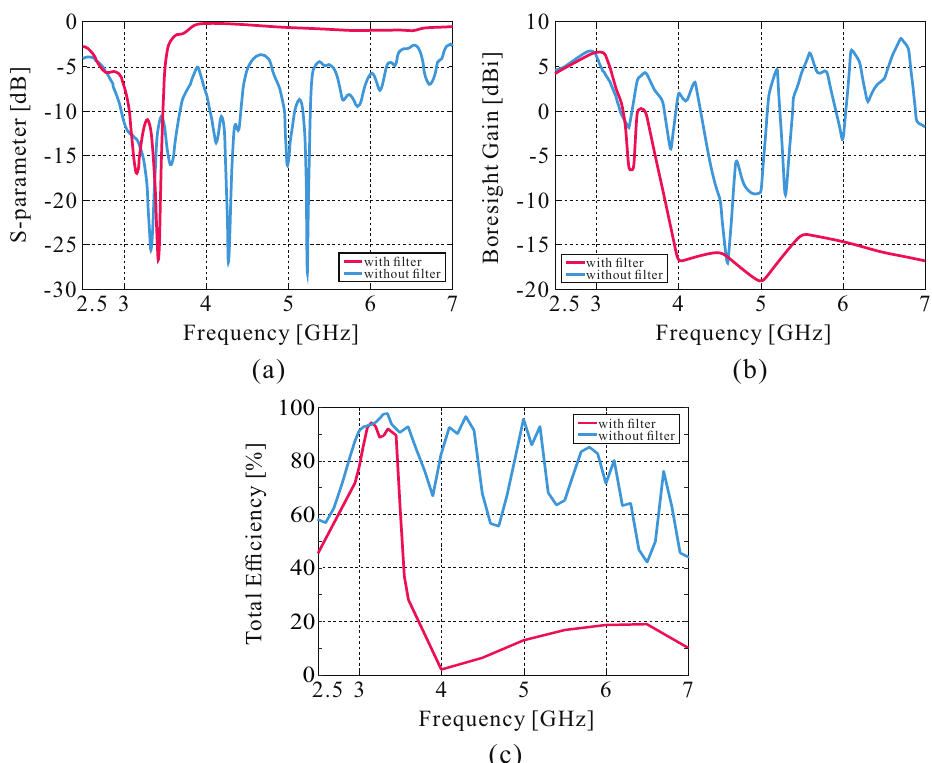
Figure 5. Simulation results of the proposed antenna with and without the filter: ( a ) the S11, ( b ) the boresight gain, and ( c ) total efficiency of the antenna.